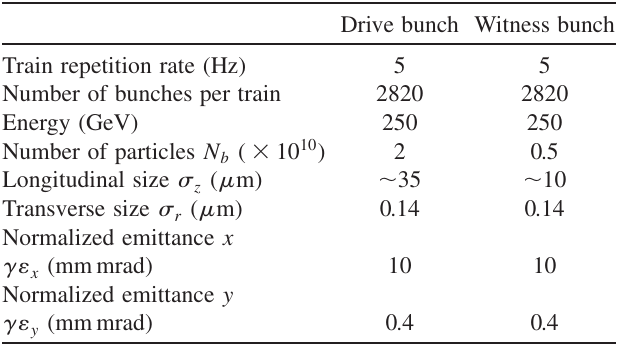
FIG. 2. (a) Schematic of the drive bunch, witness bunch, and ions distribution behind the drive bunch in the case of immobile ions: the ion column density is uniform. (b) Corresponding focusing force at the position of the witness bunch ( 1 : 25 (cid:2) z behind the drive bunch peak) calculated for the case of n i ¼ ¼ 0 : 9 (cid:3) 10 16 cm (cid:1) 3 . The force is linear over the transverse n e bunch extent. (c) Schematic for the mobile ions case. (d) Corresponding nonlinear focusing force obtained from simu- lations showing the resulting radial nonlinearity. Witness bunch transverse size (cid:2) x ¼ 0 : 14 (cid:5) m . the witness bunch can be matched to the plasma ion column focusing force { (cid:2) r ¼ ½ð 1 = 2 (cid:3)r e Þð " 2 (cid:6)=n e Þ(cid:5) 1 = 4 , see Eq. (2) below}, leading to a focused size at the plasma entrance in the submicrometer range. Table I shows the typical parameters of beams in future PWFA-based accel- erator. Note that these parameters correspond to a PWFA energy doubling scenarios known as the plasma after- burner [9] with ILC parameters. Other scenarios including using lower energy drive bunches ( (cid:2) 25 GeV ) and a large number ( (cid:2) 20 ) of meter-long plasma stages are currently also considered. Ion motion [5] is weakly dependent on the beam energy ( (cid:2) (cid:6) 1 = 4 ) and the ion temperature necessary to counter ion motion is independent of the (relativistic) beam energy. TABLE I. Typical bunch parameters for a future PWFA-based linear collider adapted from ILC parameters